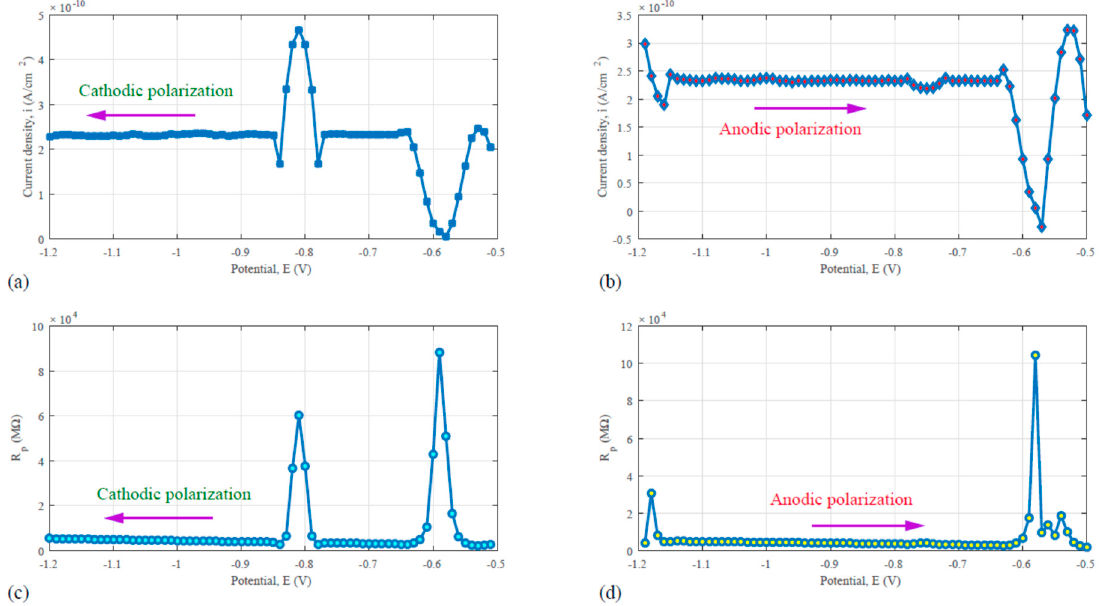
Figure 10. AC voltammograms and electrochemical impedance plots of the C / Al composite material in 0.1 N sulfuric acid: ( a ) Voltammogram generated by the cathodic polarization (downward sweep), ( b ) voltammogram generated by the anodic polarization (upward sweep), ( c ) impedance versus scanning potential in the cathodic polarization, and ( d ) impedance versus scanning potential in the anodic polarization.